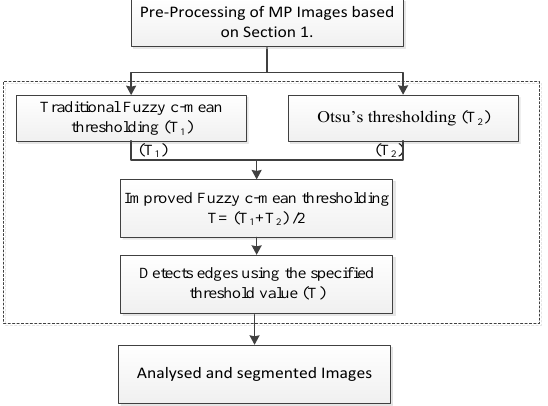
Figure 1. Flowchart of the developed Fuzzy c-mean thresholding algorithm.